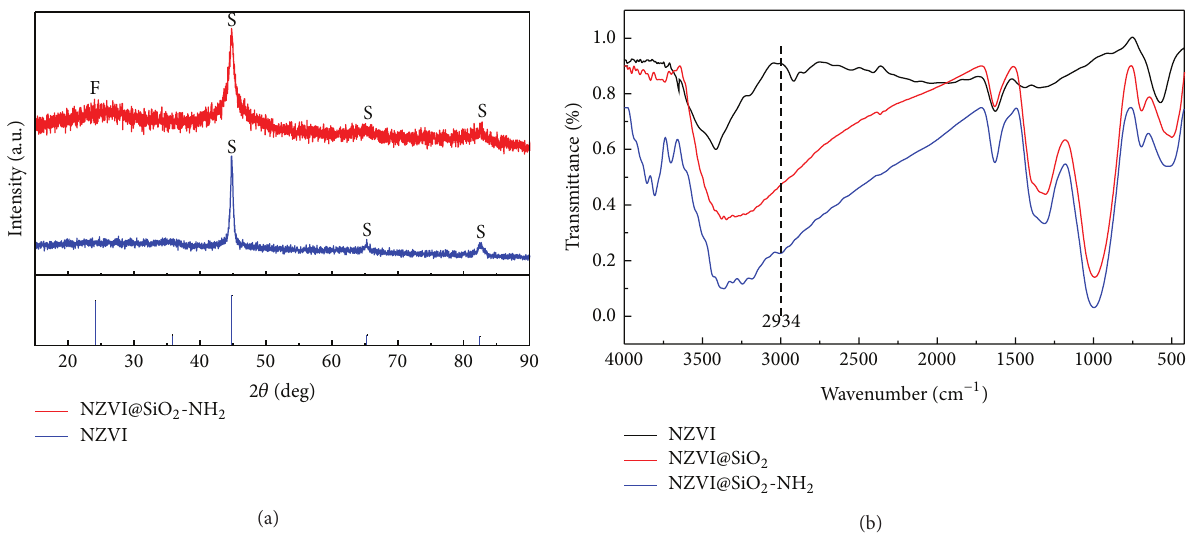
Figure 3: XRD and FT-IR patterns produced the different style iron nanoparticle.